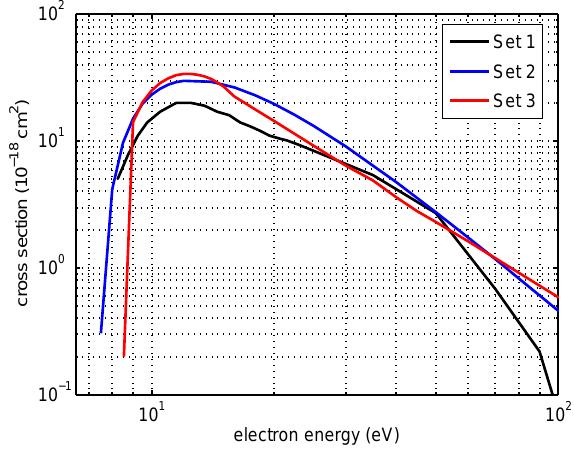
Fig. 6. Constructed emission cross sections for N 2 1P (4,1) and (5,2) bands, including all cascades from B, A, C, B 0 , W states (Set 2 and Set